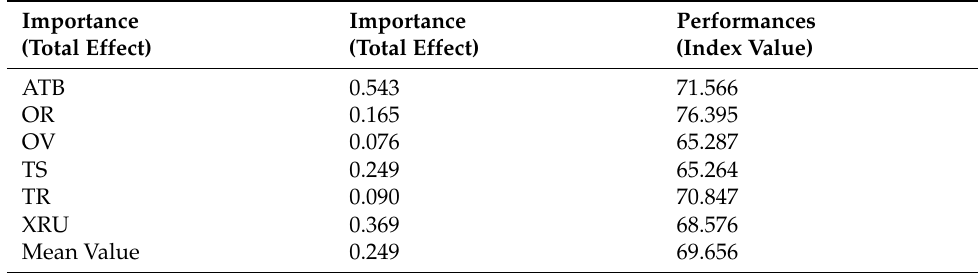
Table 10. Importance performance map